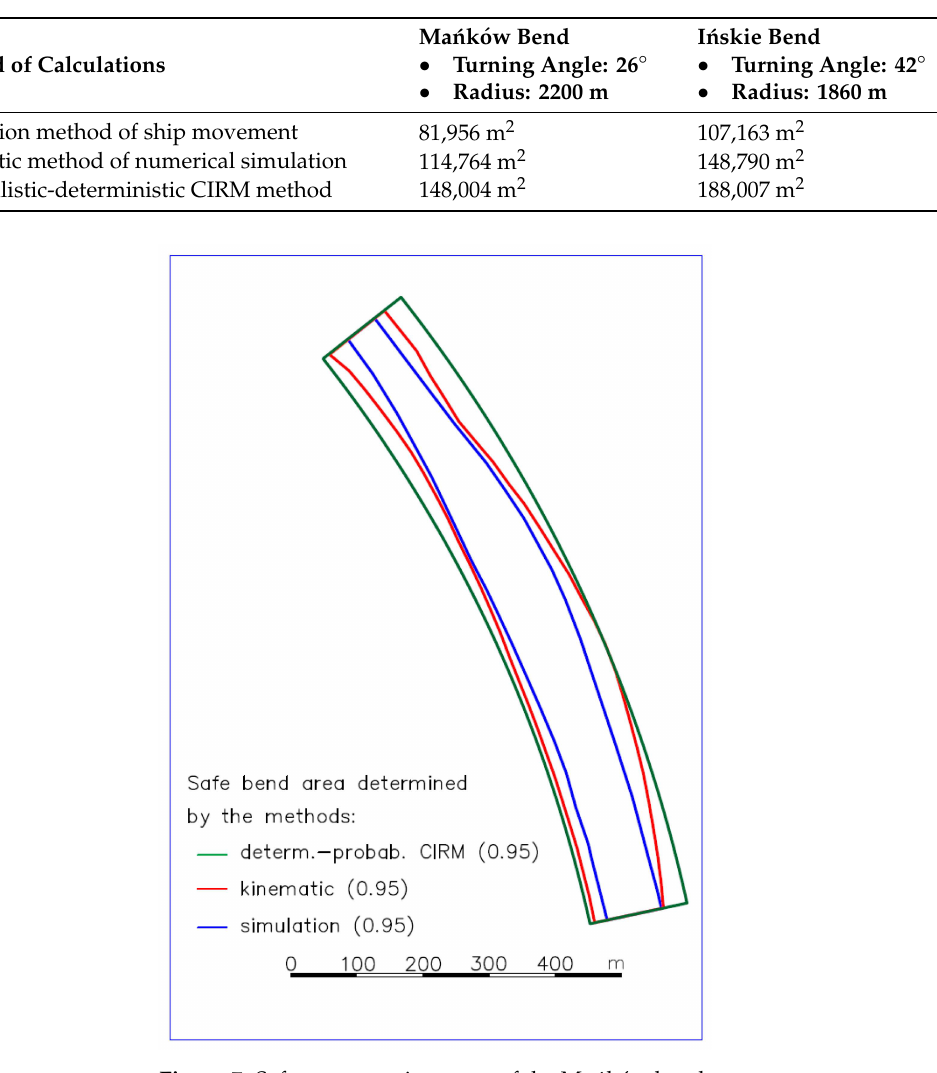
Figure 7. Safe manoeuvring areas of the Ma´nk ó w